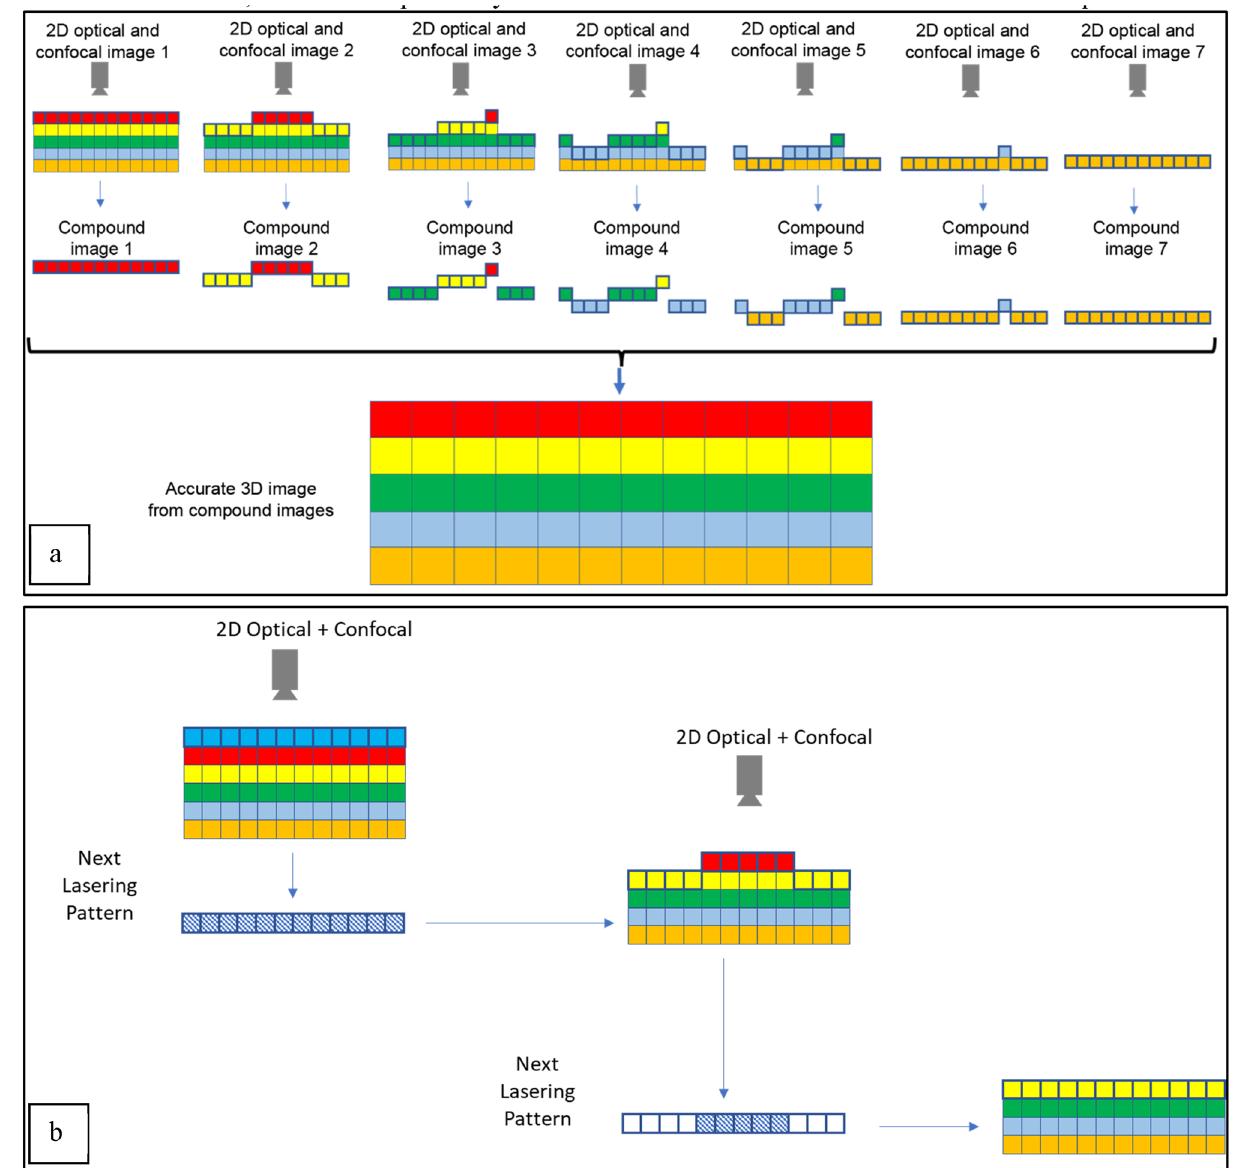
Figure 2. ( a ) Proposed approach for sampling the volume of interest addresses the distortion issue of the resulting 3D image; ( b ) Laser cutting pattern is determined based on the height profile to maintain the height variation within a certain